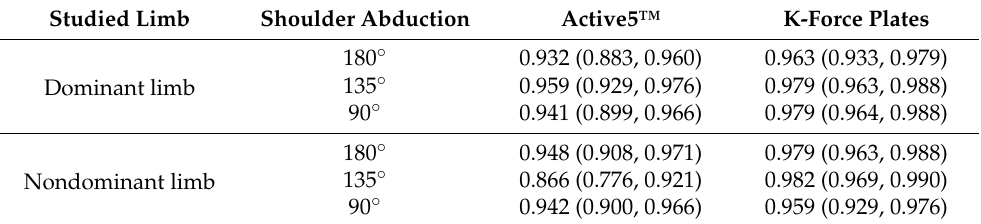
Table 2. Intrarater reliability of the ASH test in the female group using both studied devices. Studied